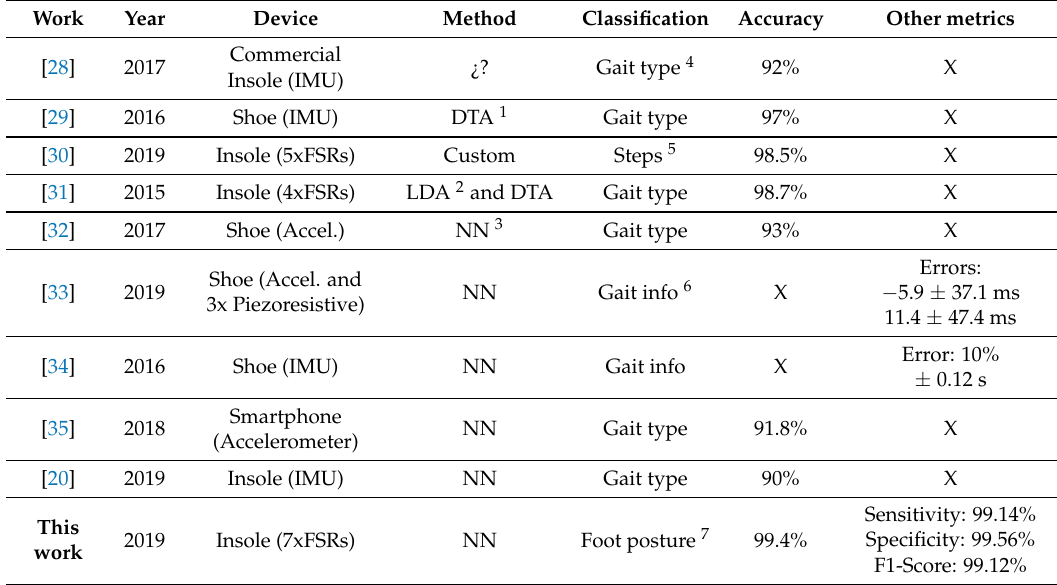
Table 7. Accuracy comparison with related